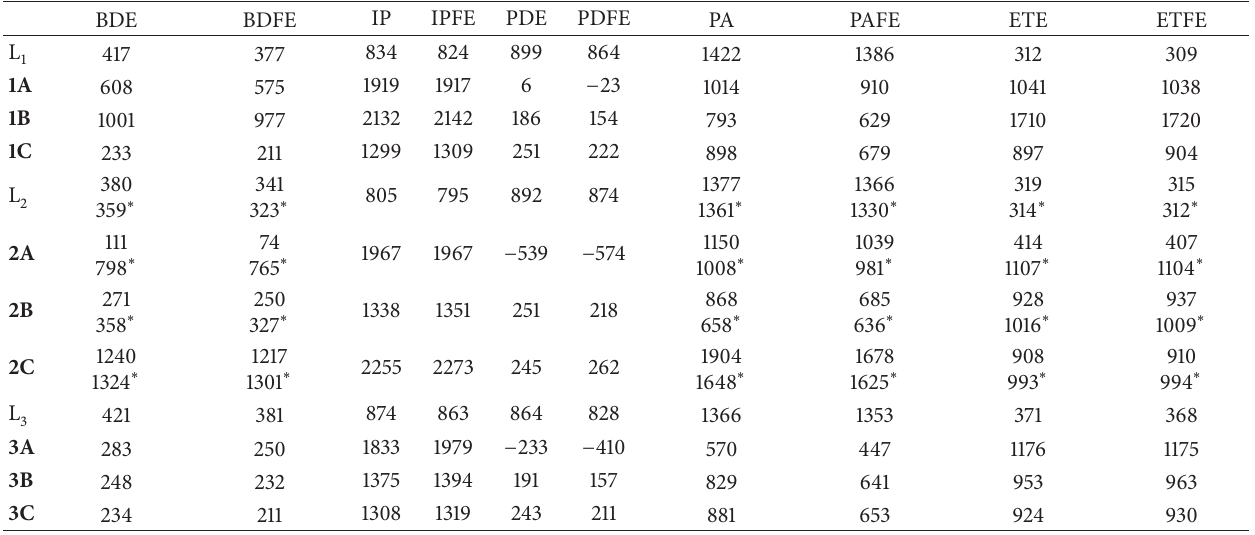
Table 4: Values of BDE, BDFE, IP, IPFE, PDE, PDFE, PA, PAFE, ETE and ETFE of the compounds studied, all in kJ/mol obtained